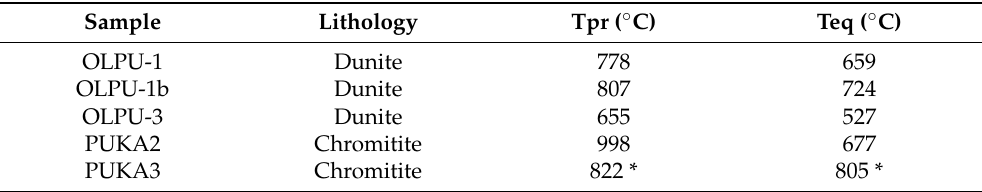
Table 6. Primary and re-equilibrated temperatures (Tpr and Teq) of Iballe chromitites and dunites.